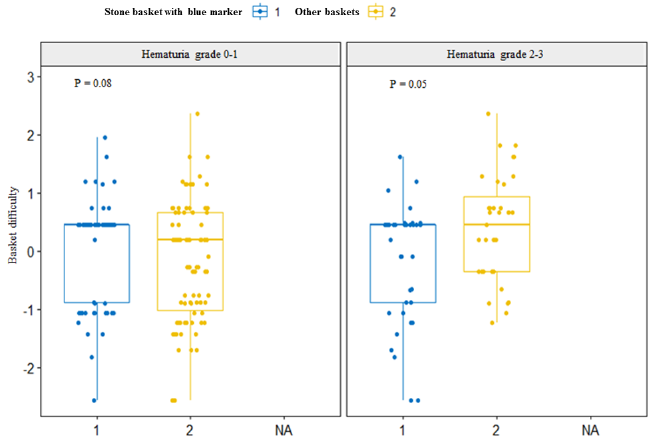
Figure 1. Assessment of basket visualization score for basketing difficulty after z-score normaliza- tion. Higher value represents more difficulty in basketing. Left side figure is for low hematuria grades of zero to one. Right side figure is for high hematuria grades of two to three. The blue box reflects stone basket with blue marker (group 1). The yellow box (group 2) reflects other baskets. Basket with blue marker shows better performance in high hematuria groups than in low hematuria groups.